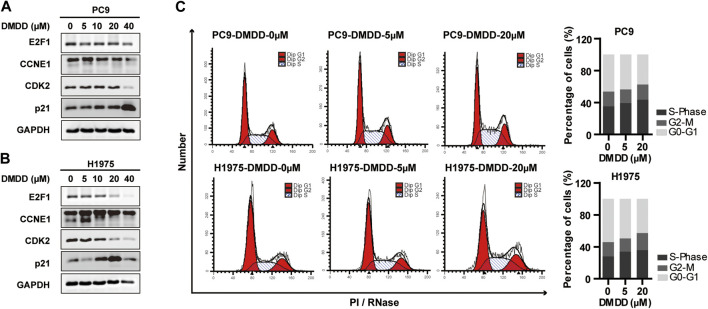
DMDD induced cell cycle arrest at the G1/S phase and potentially through CCNE1 and E2F1 regulation. (A, B) CCNE1, E2F1 and CDK2 were decreased after DMDD treatment with indicated doses for 48 h measured by Western blot in PC9 and H1975 cells. (C) DMDD treatment with indicated doses caused G1/S arrest in both PC9 and H1975 lung cells by flow cytometer.